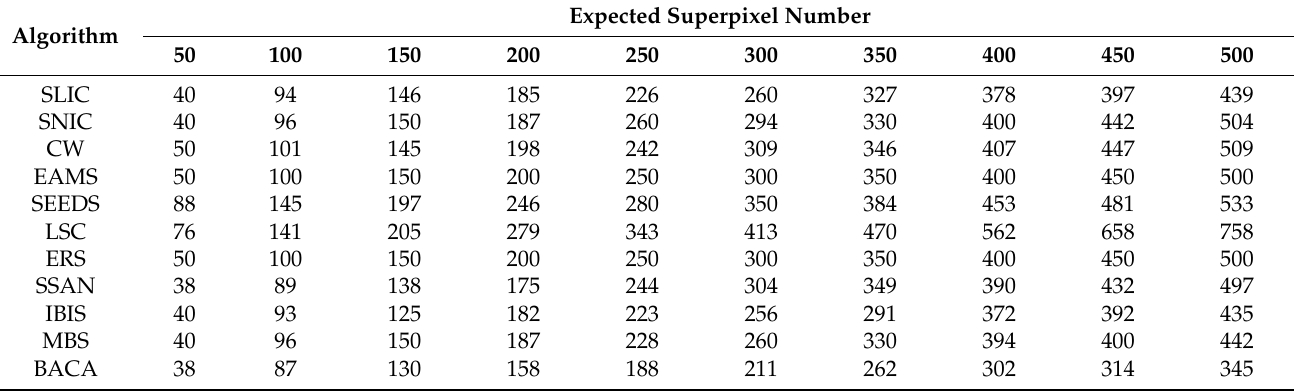
Table 1. Comparison of the superpixels number between actual generation and user-expected on the eleven algorithms.